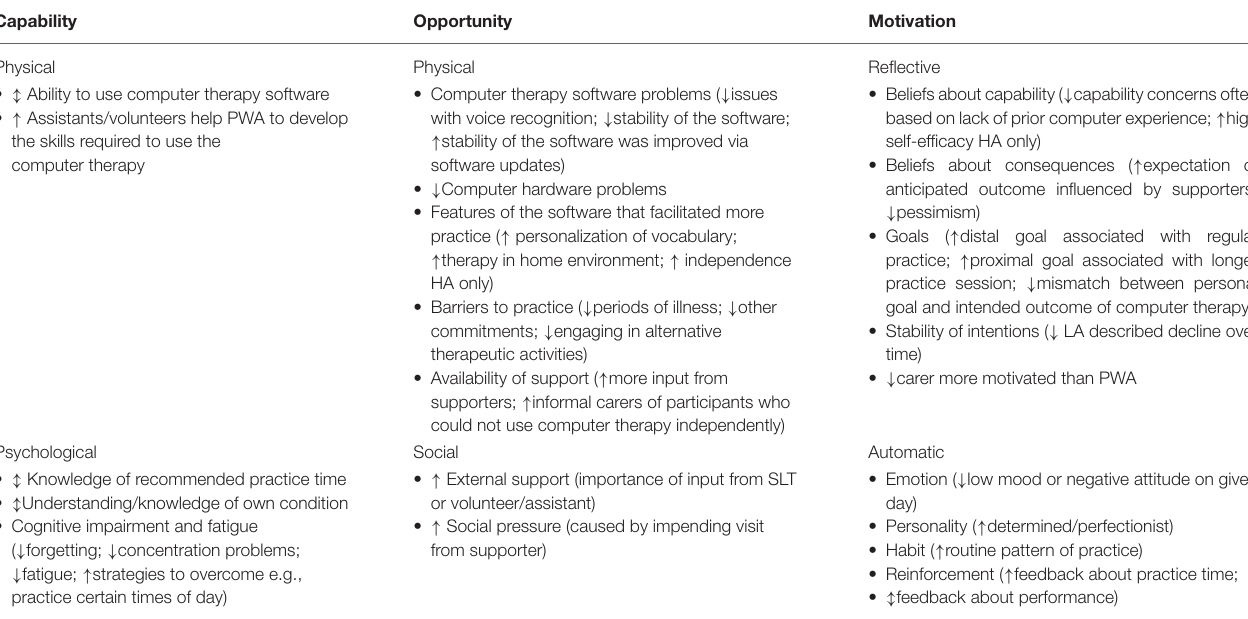
TABLE 4 | Factors associated with adherence to aphasia computer therapy categorized into themes using the COM-B